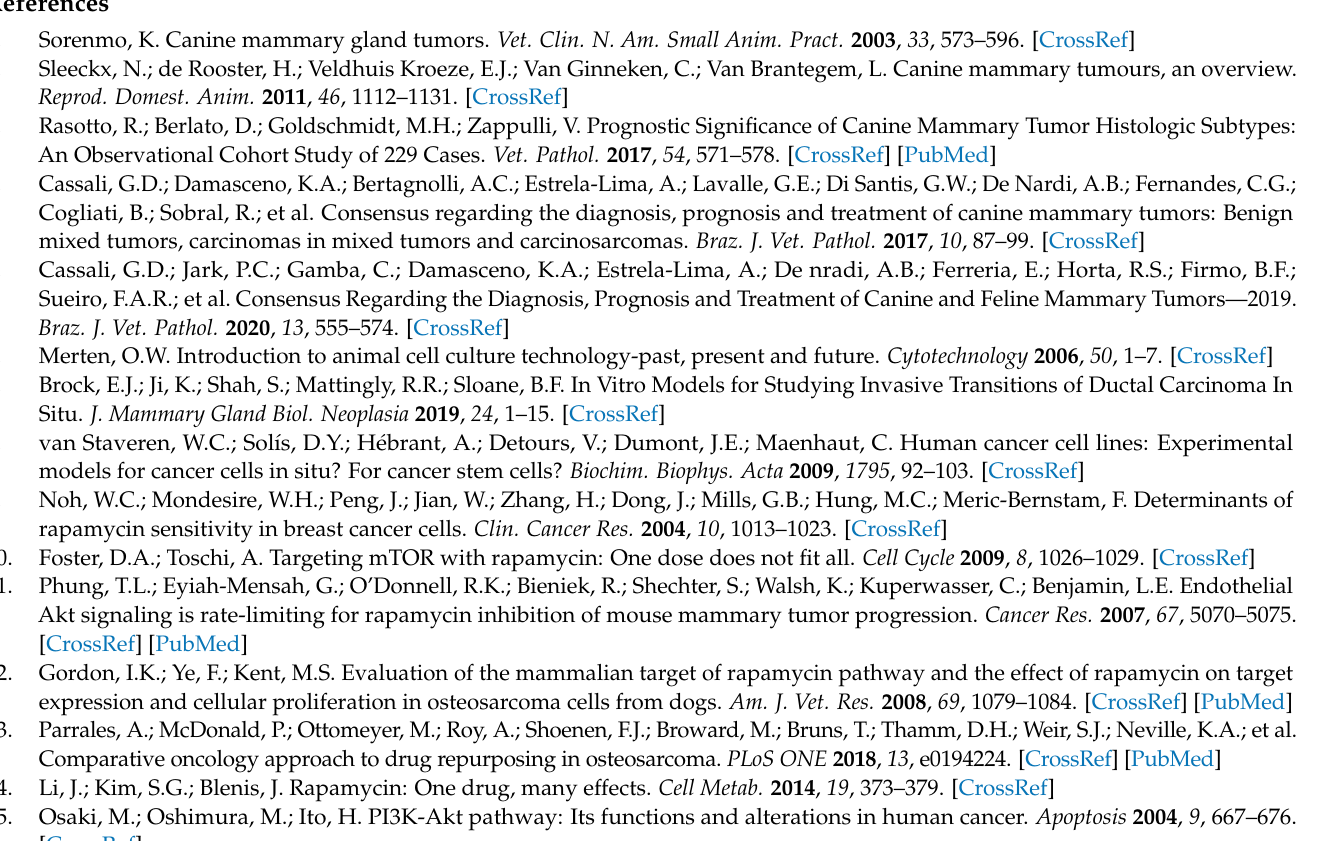
Table S7: Primary antibodies used in immunofluorescence, Table S8: Sequence of oligonucleotides from genes used for